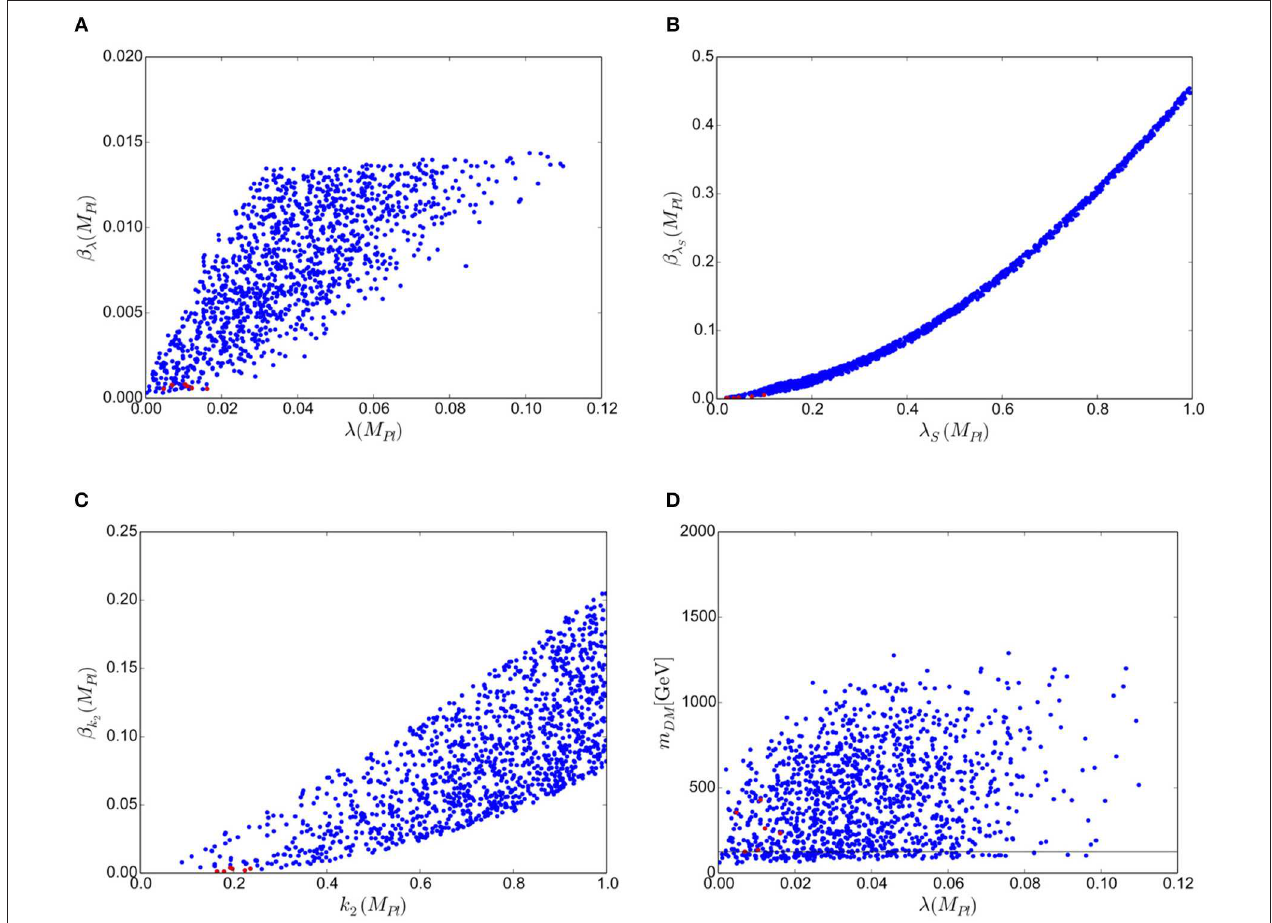
FIGURE 5 | Values of (A) λ ( M Pl ), (B) λ S ( M Pl ) and (C) λ ( M Pl ) compared to their respective β -functions in the Dark Matter phase. All points pass theoretical and experimental constraints. Red points further obey β λ < 0.0009, β λ λ ( M Pl